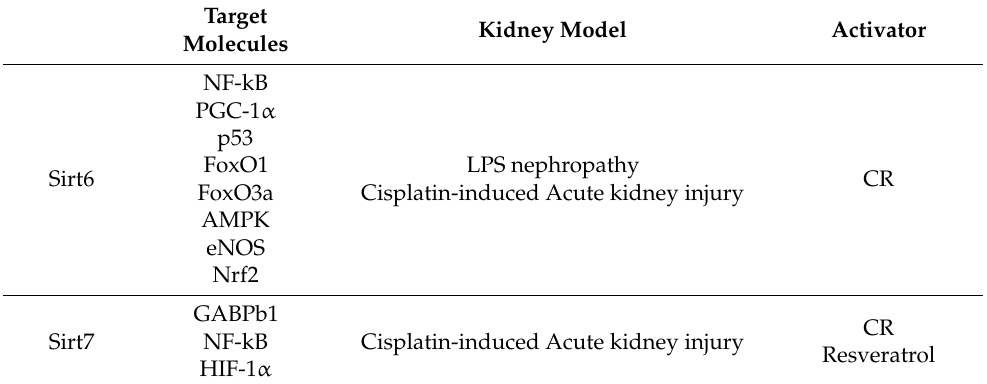
Table 4. Molecules targeted by sirt6 and sirt7 for regulation of the oxidative stress and the activator of sirt6 and